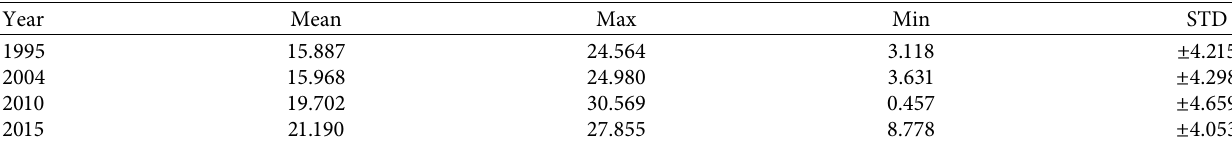
Figure 4: LST 1995 (a), 2004 (b) 2010 (c), and 2015 (d) distributions. Table 3: Statistical analysis for the extraction LST ( °